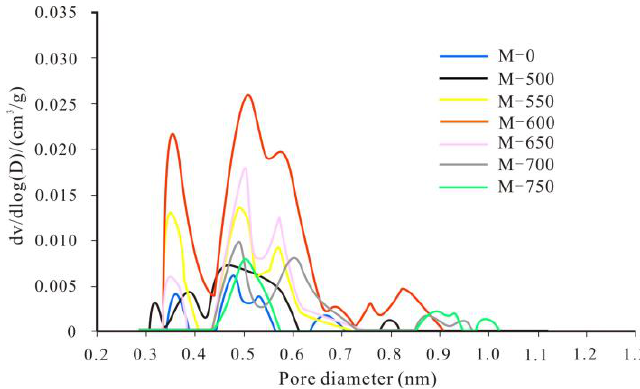
Figure 3. Pore size distribution (PSD) derived from CO 2 adsorption for the shale samples at different temperatures.